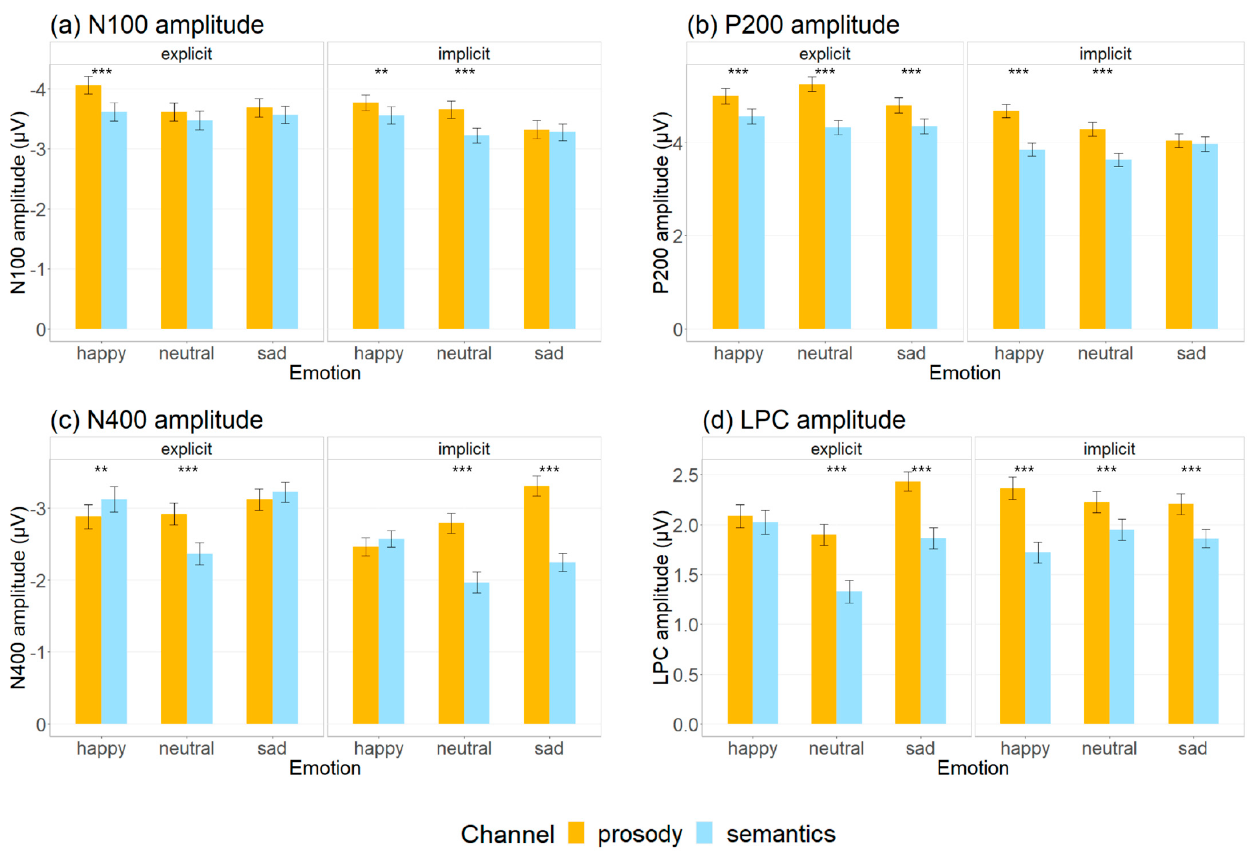
Figure 3. Bar plots of auditory ERP amplitude of ( a ) N100, ( b ) P200, ( c ) N400 and ( d ) LPC for happy, neutral and sad stimuli in prosodic and semantic channels across explicit and implicit tasks. Mean amplitude is displayed in the bar charts with error bars showing 95% confidence intervals. Asterisks mark the significance level: ** p < 0.01; *** p < 0.001. Table 1. Effects that reached significance for auditory ERP and behavioral results.